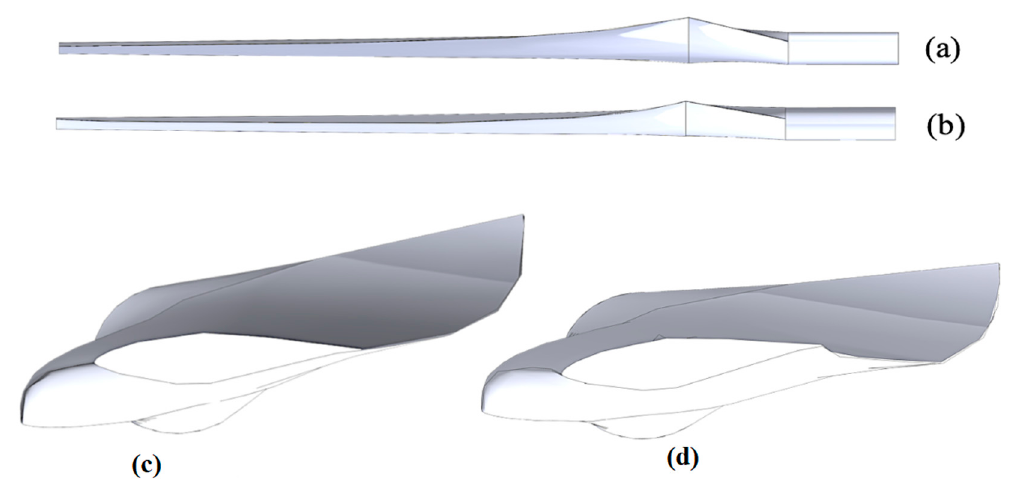
Figure 20. Side view of the ( a ) original and ( b ) optimized blade (top); End view of the ( c ) original and ( d ) optimized (bottom).